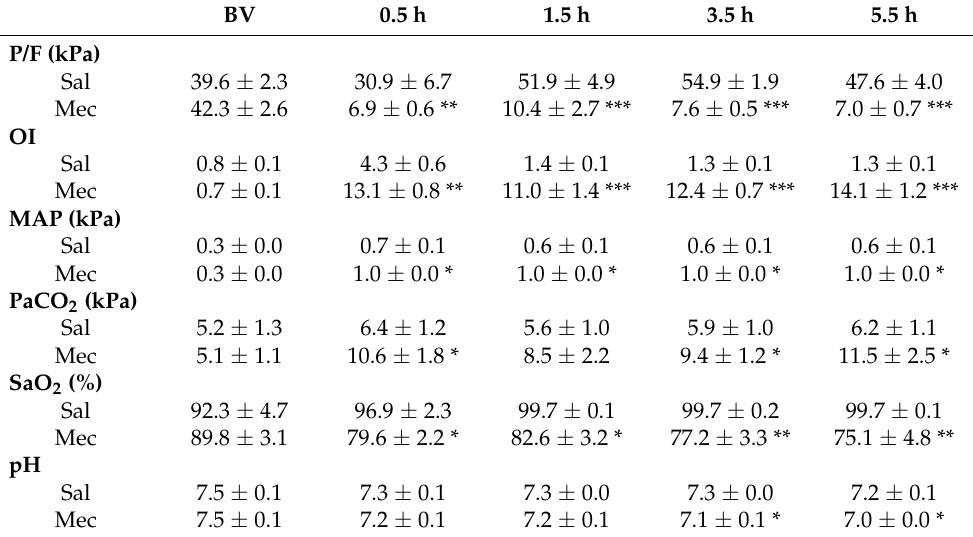
Table 2. Respiratory parameters. The ratio of partial pressure of arterial oxygen to inspired oxygen fraction (P/F, kPa), oxygenation index (OI), mean alveolar pressure (MAP, kPa), partial pressure of carbon dioxide (PaCO 2 , kPa), oxygen saturation in arterial blood (SaO 2 , %) and pH during the experiment (basal value, BV) in the saline (Sal) and meconium (Mec) groups. Statistical comparisons for Mec vs. Sal * p < 0.05, ** p < 0.01, *** p < 0.001.